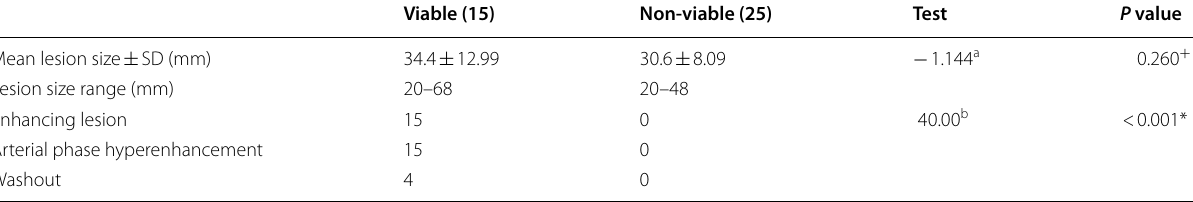
Table 1 Size and enhancement of the radiofrequency-ablated HCC